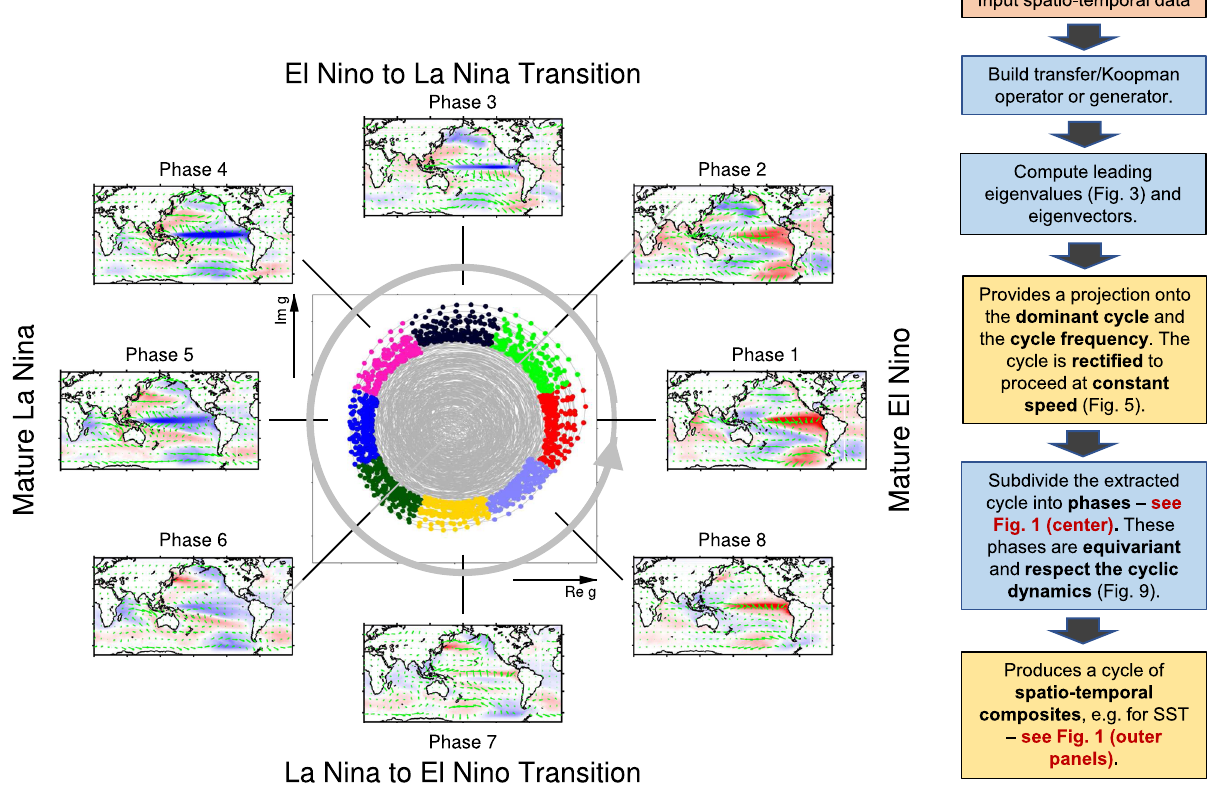
Fig. 1 Operator-derived lifecycle of the El Niño Southern Oscillation (ENSO). Left: Schematic representation of the canonical ENSO lifecycle recovered from a control integration of the Community Climate System Model version 4 (CCSM4). Center panel: 2D phase space associated with the real and imaginary parts of the eigenfunction g of the generator representing ENSO. Each point in the 2D phase space represents an ENSO state. Dynamical evolution progresses in an approximately cyclical manner via counter-clockwise rotation. The period of the cycle is equal to 2 π / α ≈ 4 yr, where α is the imaginary part of the eigenvalue corresponding to g . The 2D phase space is partitioned into S = 8 “ wedges ” of equal angular extent (distinguished by different solid colors), each corresponding to a distinct ENSO phase. Outer panels: The panels linked to each wedge are phase composites of sea surface temperature (SST) (colors) and surface wind anomaly fi elds (green arrows). Collectively, they reveal a complete ENSO cycle, starting from a mature El Niño in Phase 1, and progressing to an El Niño to La Niña transition in Phase 3, mature La Niña in Phases 4 – 5, and La Niña to El Niño transition in Phase 7. The identi fi ed phases are equivariant, meaning that they each span a time interval of 2 π /( S α ) ≈ 0.5 yr, and under forward dynamical evolution by 0.5 yr the samples making up phase i correlate strongly with the samples making up phase i + 1. By virtue of this property, the generator-based ENSO lifecycle captures the duration asymmetry between the El Niño to La Niña and La Niña to El Niño transition. This is evidenced by the fact that the strongest La Niña anomalies occur in Phase 4, as opposed to Phase 5 (which would be expected for a time-symmetric oscillation). Right: Flow chart of the computational approach for identi fi cation of slowly decaying cycles through eigenfunctions of transfer/Koopman operators. Red-, blue-, and orange-shaded boxes represent input, computation, and output,